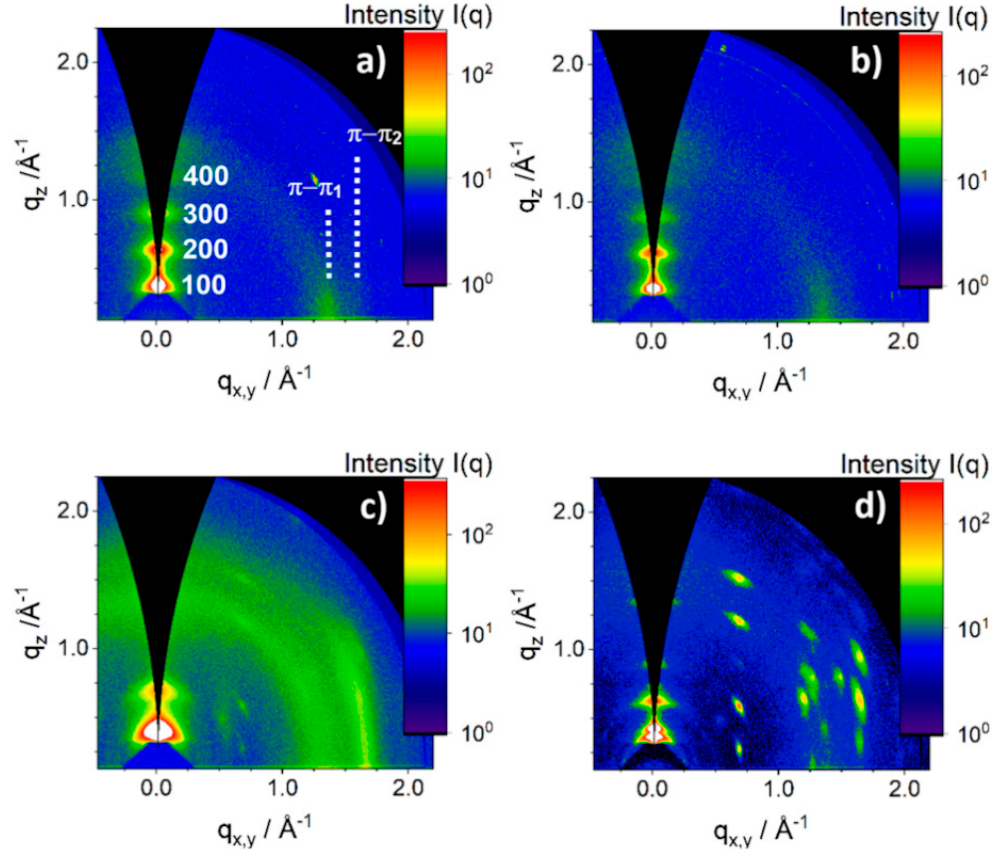
Figure 6. Grazing incidence wide-angle X-ray scattering (GIWAXS) patterns of PBTTT-C 14 spin coated at 3000 rpm from a 100 ◦ C hot solution ( a ) before and ( b ) after annealing at 200 ◦ C and PBTTT-C 14 :PDI8-CN 2 spin coated at 3000 rpm from solution at 100 ◦ C ( c ) before and ( d ) after annealing at 200 ◦ C. Numbers in the pattern ( a ) denote the peaks corresponding to h00 Bragg series of PBTTT-C 14 .